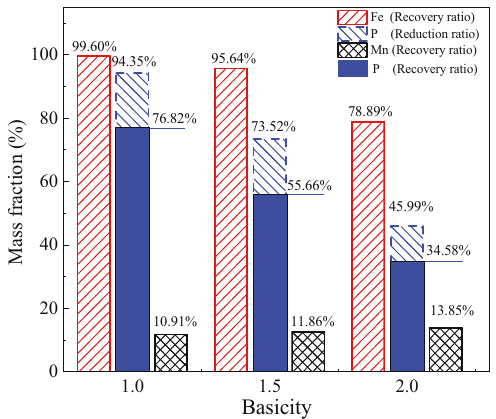
Figure 5: Reduction and recovery ratios of valuable elements after experiments.